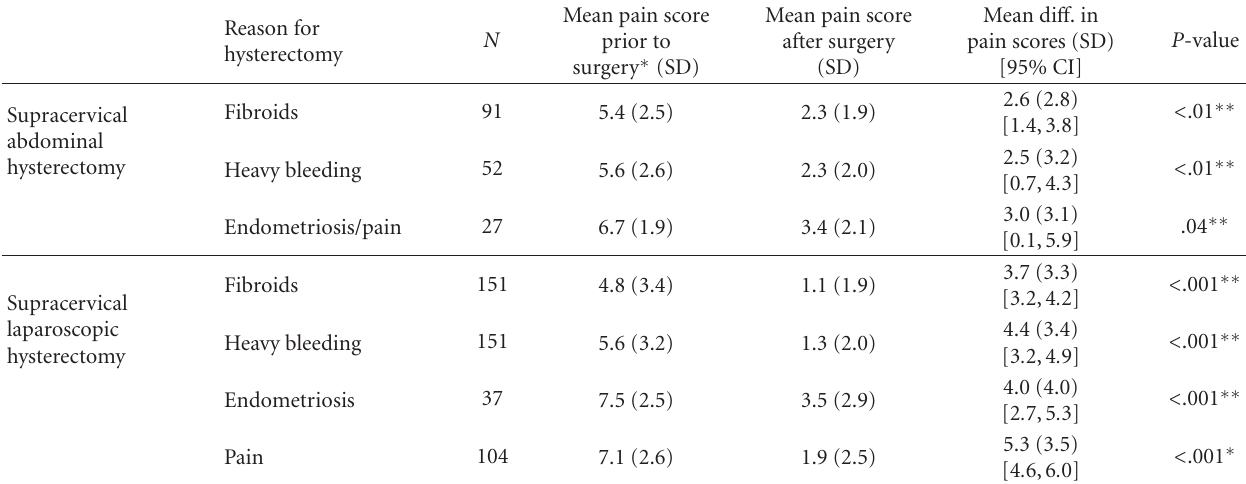
Table 2: Pain intensity prior to and after surgery by reasons for hysterectomy.